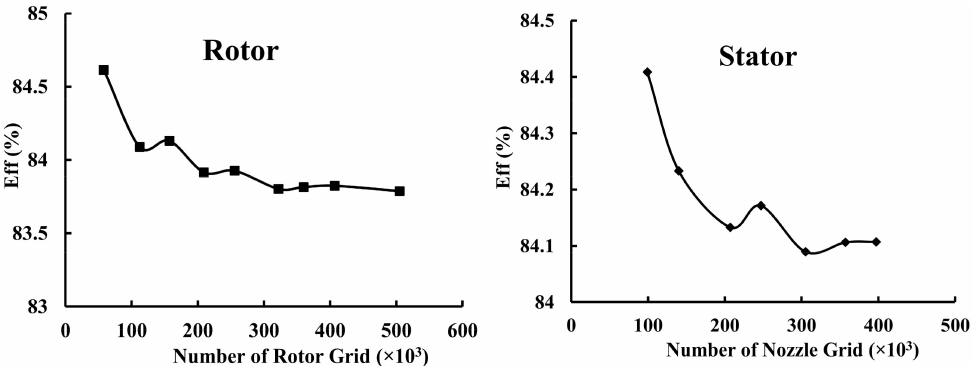
Figure 11. Grid independency for the rotor and nozzle blade rows.